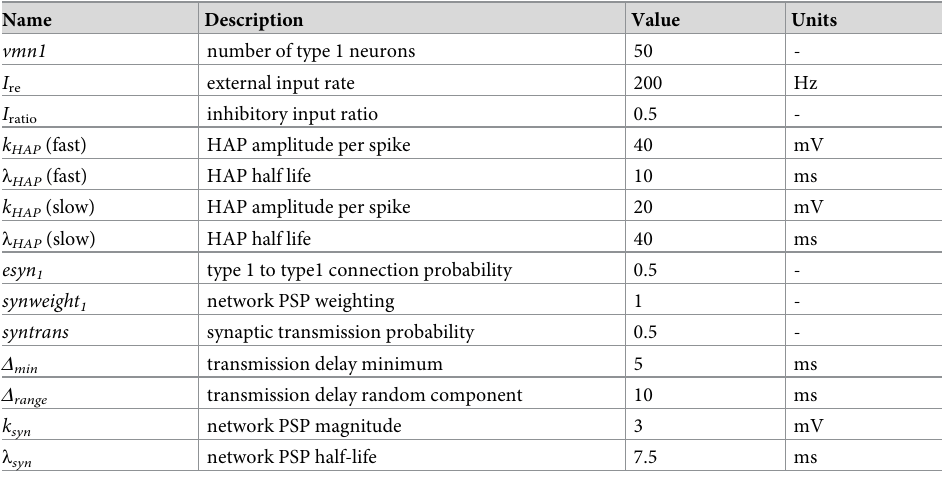
Table 3. Single cell type network model parameters (others as in Table